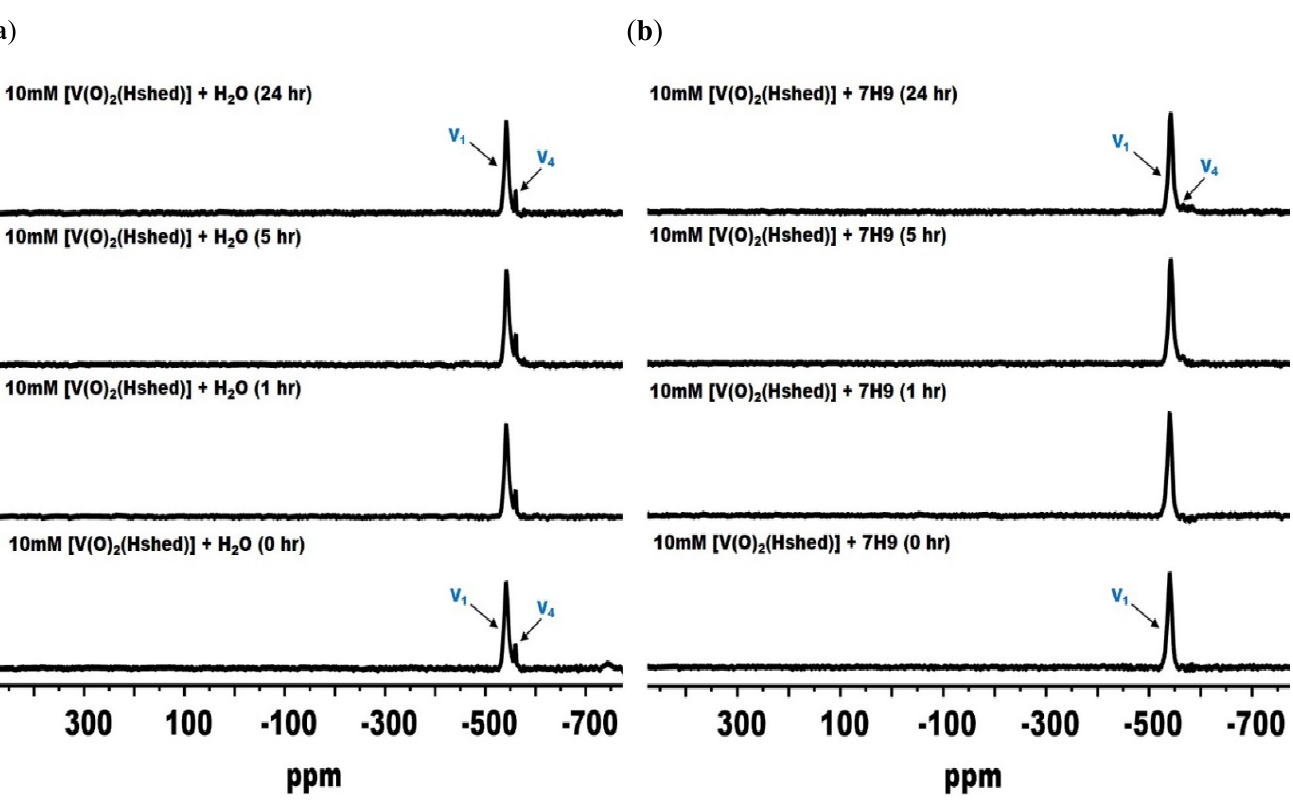
Figure 7. The 51 V NMR spectra of 10 mM [V(O) 2 (Hshed)] at 0, 1, 5, and 24 h time points in ( a ) H 2 O:DMSO (50:50) and in ( b ) 7H9 growth medium:DMSO (50:50).